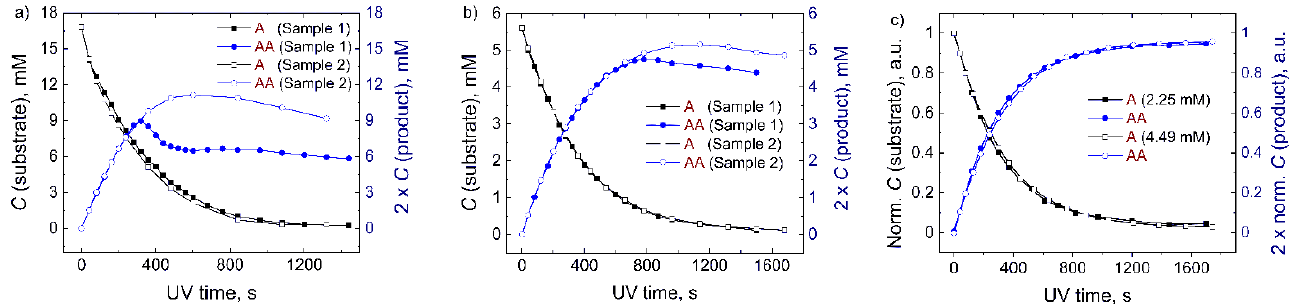
Figure 3. The effect of the precipitation on the photodimerization curves ( λ = 365 nm) derived from 400 MHz 1 H-NMR spectra of anthracene ( A ) and its dimer ( AA ). Each experiment was repeated on two separate samples (sample 1 and sample 2) prepared from the same batch. The precipitation was observed ( a , b ) until the concentration of anthracene was reduced to 4.5 mM, and no further effect of concentration on kinetics was noticed ( c ).